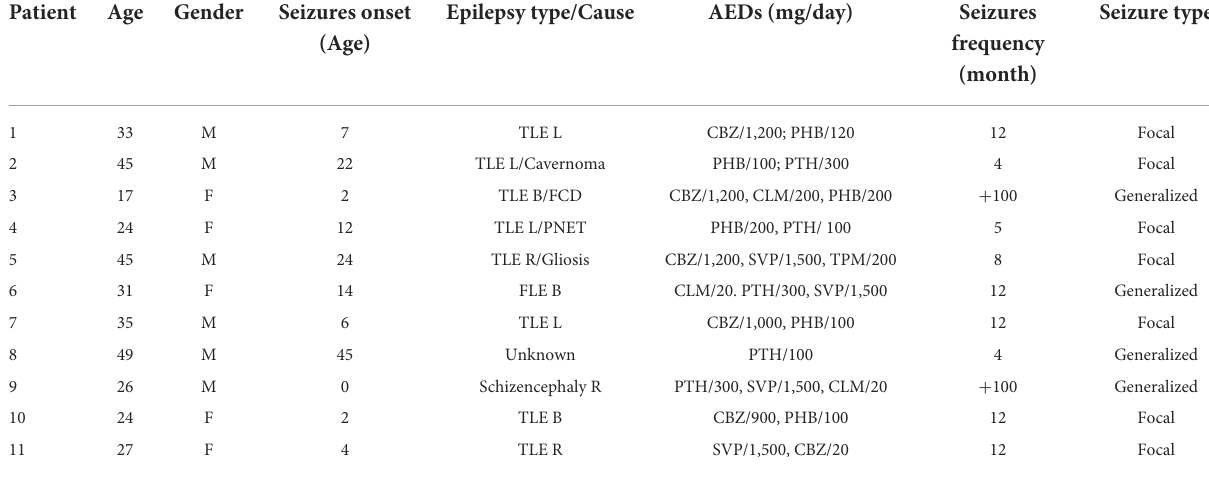
TABLE 1 Clinical data for the evaluated